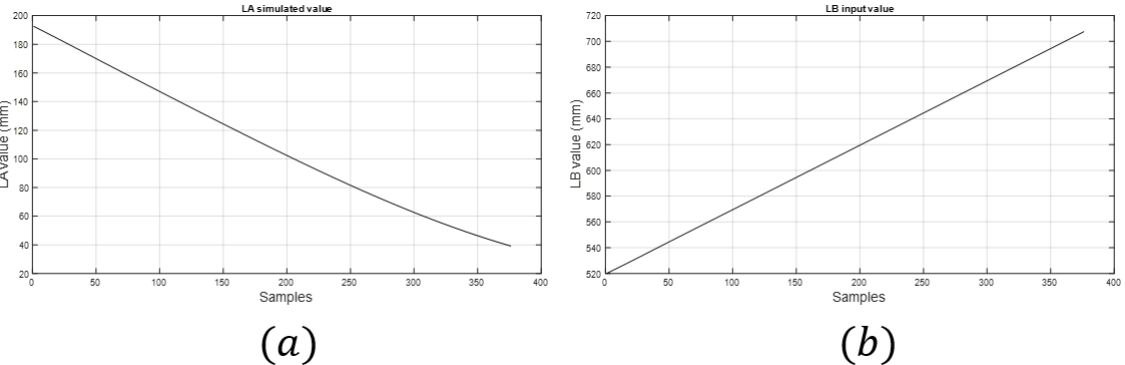
Figure 13. ( a ) Values of LA simulated that are considered in the kinetostatic method as the sensor value. ( b ) Input values of LB, length of controlled cable.